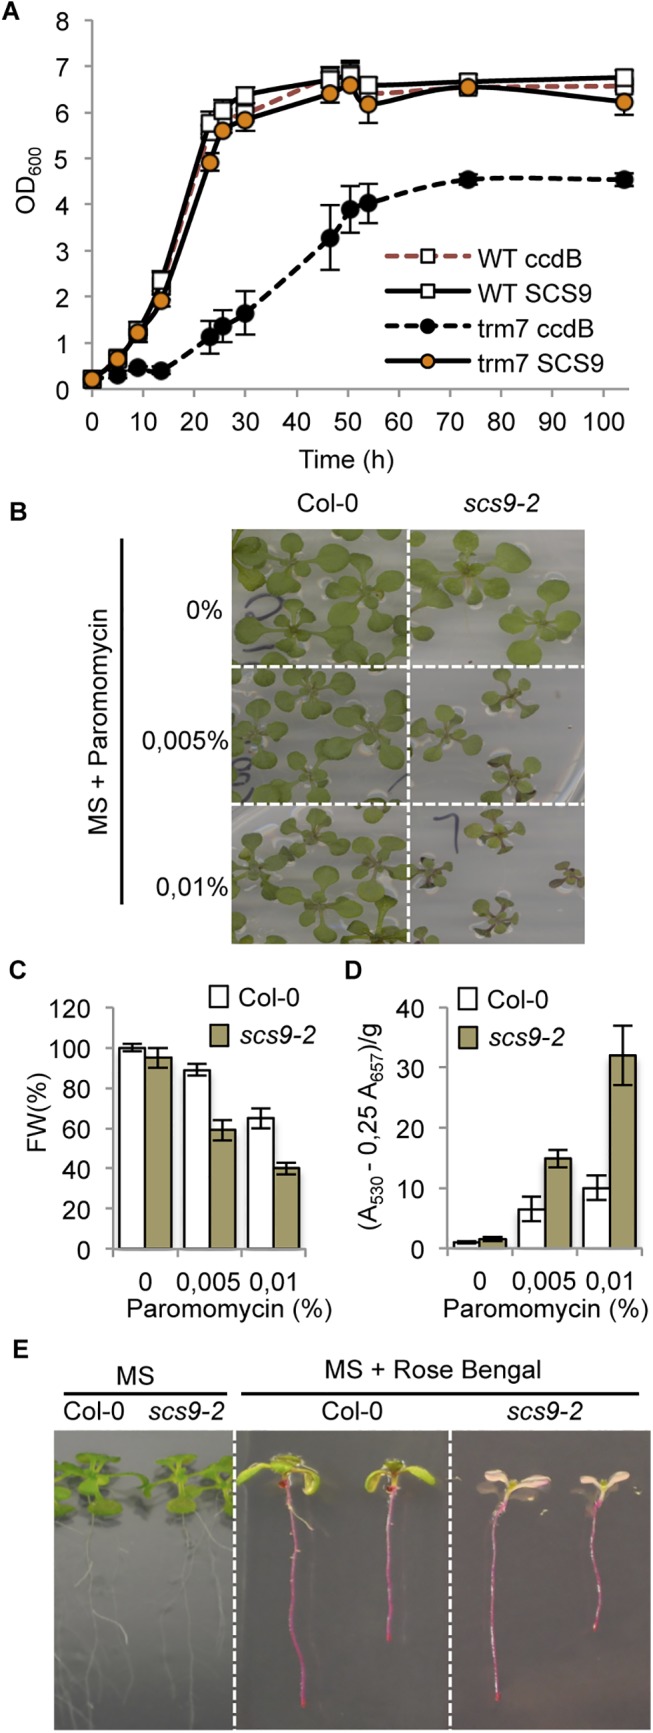
Complementation of the Saccharomyces cerevisiae trm7Δ strain with Arabidopsis SCS9 cDNA, and hypersensitivity of scs9-2 seedlings to paramomycin and rose bengal.(A) Comparative growth curves of various S. cerevisiae strains grown in YPD at 30°C. Open squares represent wild-type strains (BMA64) transformed with plasmid p423-GAL1 alone (WT ccdB; broken red line) or using a plasmid carrying an Arabidopsis SCS9 cDNA (WT SCS9; black line). Filled circles represent trm7Δ strain transformed with the plasmid alone (trm7 ccdB; dark circles) or with the plasmid carrying the Arabidopsis SCS9 cDNA (trm7 SCS9; orange circles). (B) Col-0 and scs9-2 seedling growth in MS plates alone or in the presence of 0.005% (w/w) and 0.01% (w/w) of paramomycin. (C) Quantitative analysis of paramomycin effects on growth retardation in Col-0 and scs9-2 seedlings measured as reduction in fresh weight (FW). (D) Quantitative analysis of anthocyanins accumulation in Col-0 and scs9-2 seedlings treated with paramomycin at the indicated concentrations. (E) Differential effects of rose bengal on growth inhibition of Col-0 and scs9-2 seedlings grown in MS plates.